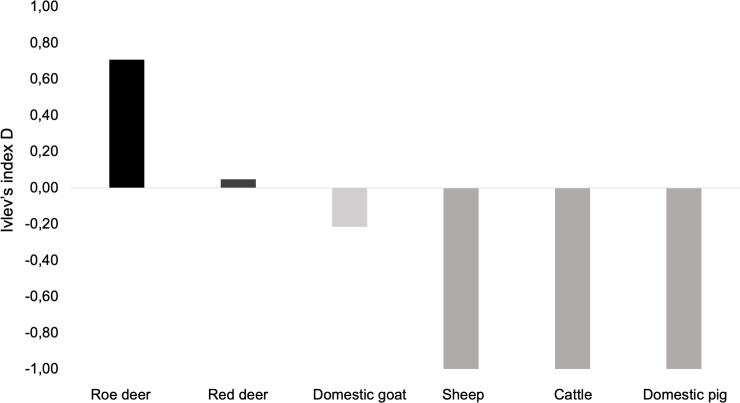
Prey selectivity (Ivlev’s index D) calculated for roe deer Capreolus capreolus, red deer Cervus elaphus, domestic goat Capra hircus, sheep Ovis aries, cattle Bos taurus and domestic pig Sus scrofa domesticus based on Iberian wolf scat analysis (n = 85) in Montesinho Natural Park, northeast Portugal.The wolf selects species with positive index values, while species with negative index are negatively selected.